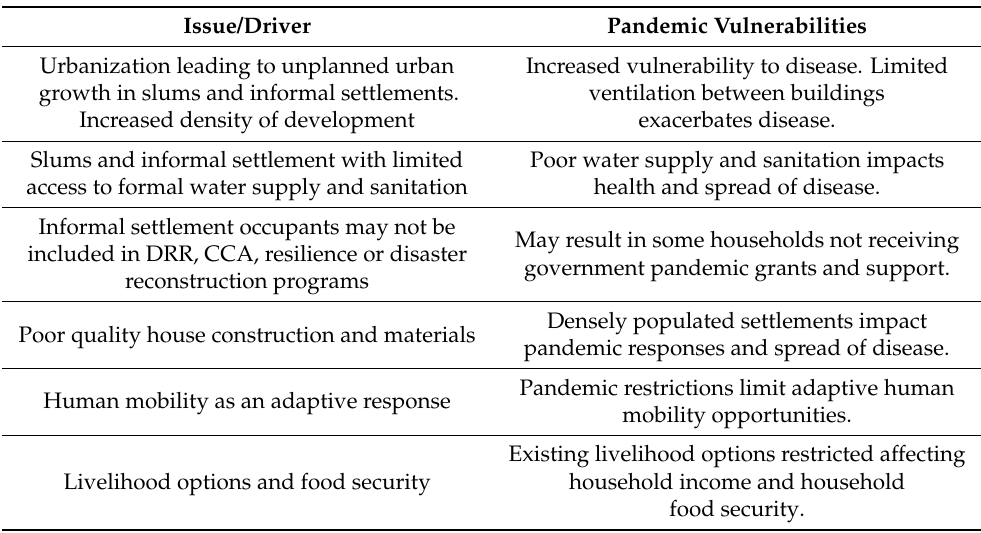
Table 1. Major issues and drivers impacting pandemic vulnerability. Issue/Driver Pandemic Vulnerabilities Urbanization leading to unplanned urban Increased vulnerability to disease. Limited growth in slums and informal settlements. ventilation between buildings Increased density of development exacerbates